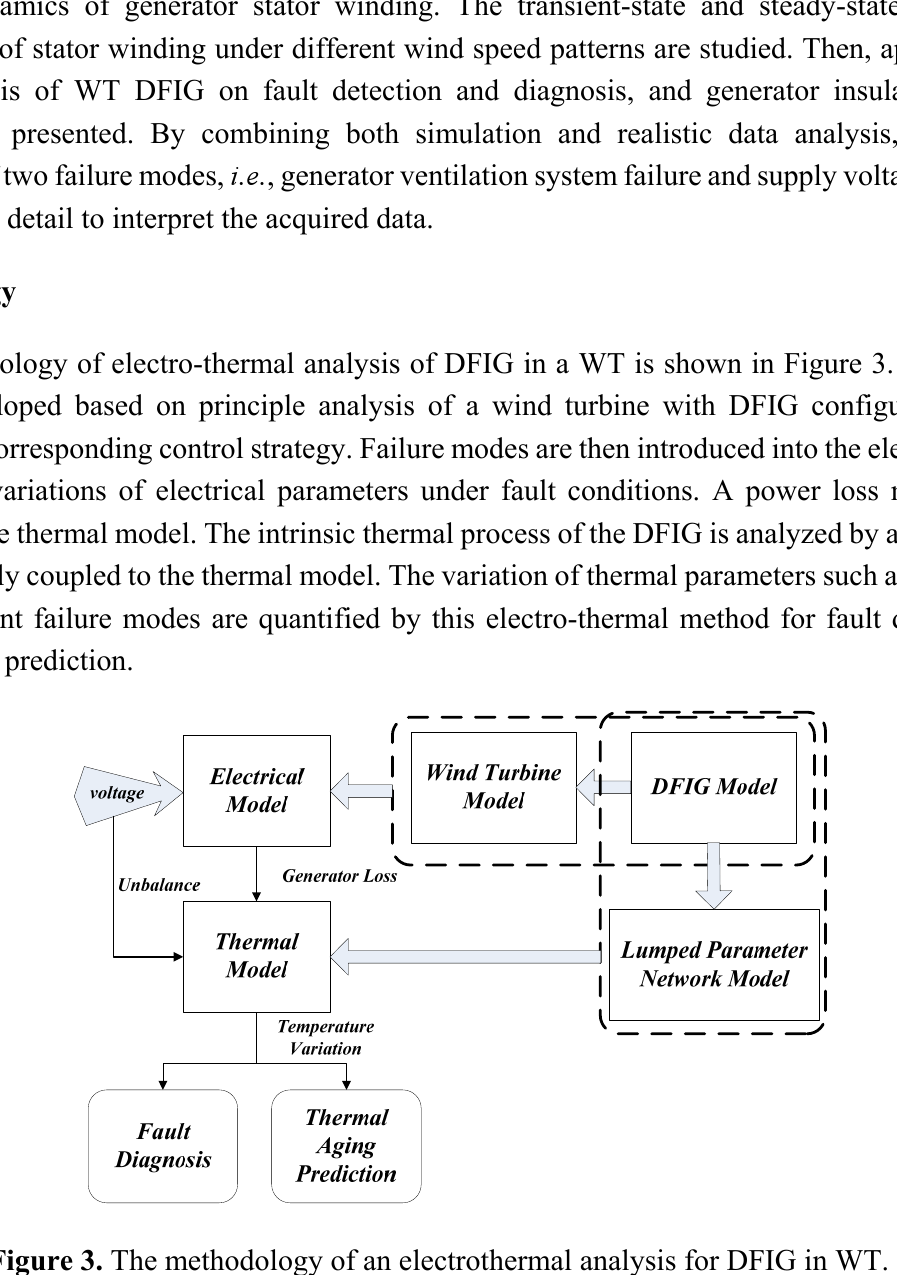
Figure 3. The methodology of an electrothermal analysis for DFIG in